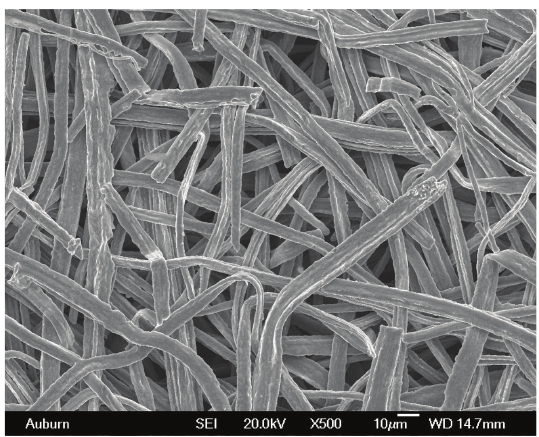
Figure 1: SEM image of nickel sintered metal microfibrous (SMM) matrix made with 4 µ m (dia.) nickel microfibers.